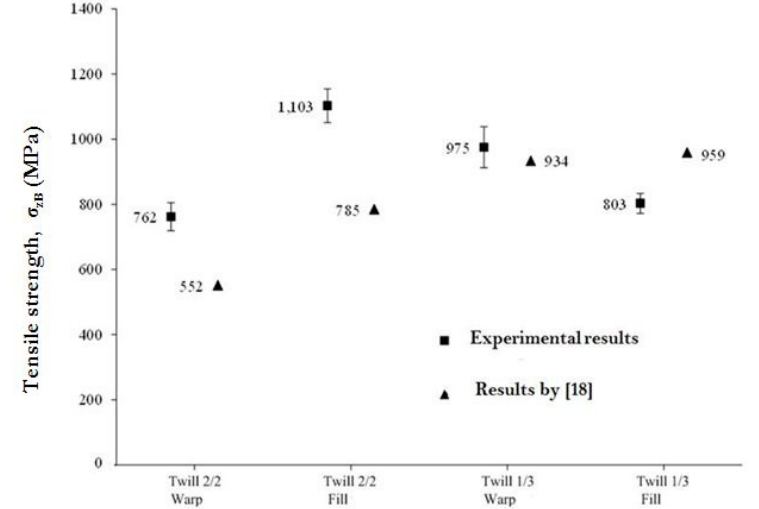
Figure 12: Calculated tensile strengths of the respective textile semi-finished products standardized to a fibre volume content of φ f